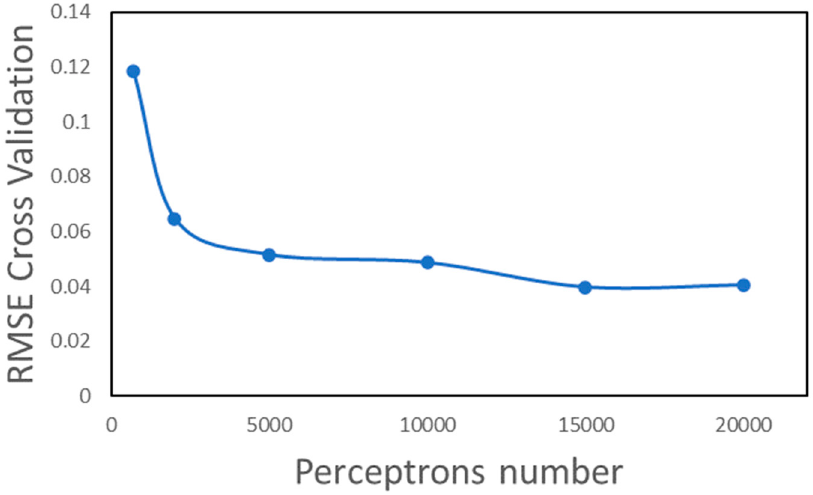
Figure 5. RMSE cross-validation values for setting the number of perceptrons. It is set up to 15,575 distributed in 7 layers.